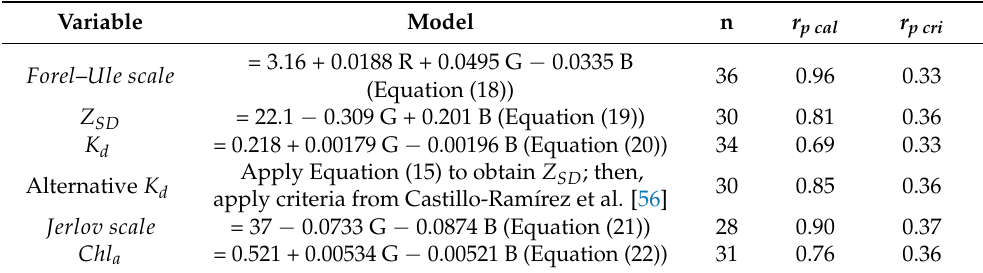
Table 4. Results of the validation analysis of the models for the general approach. Variable